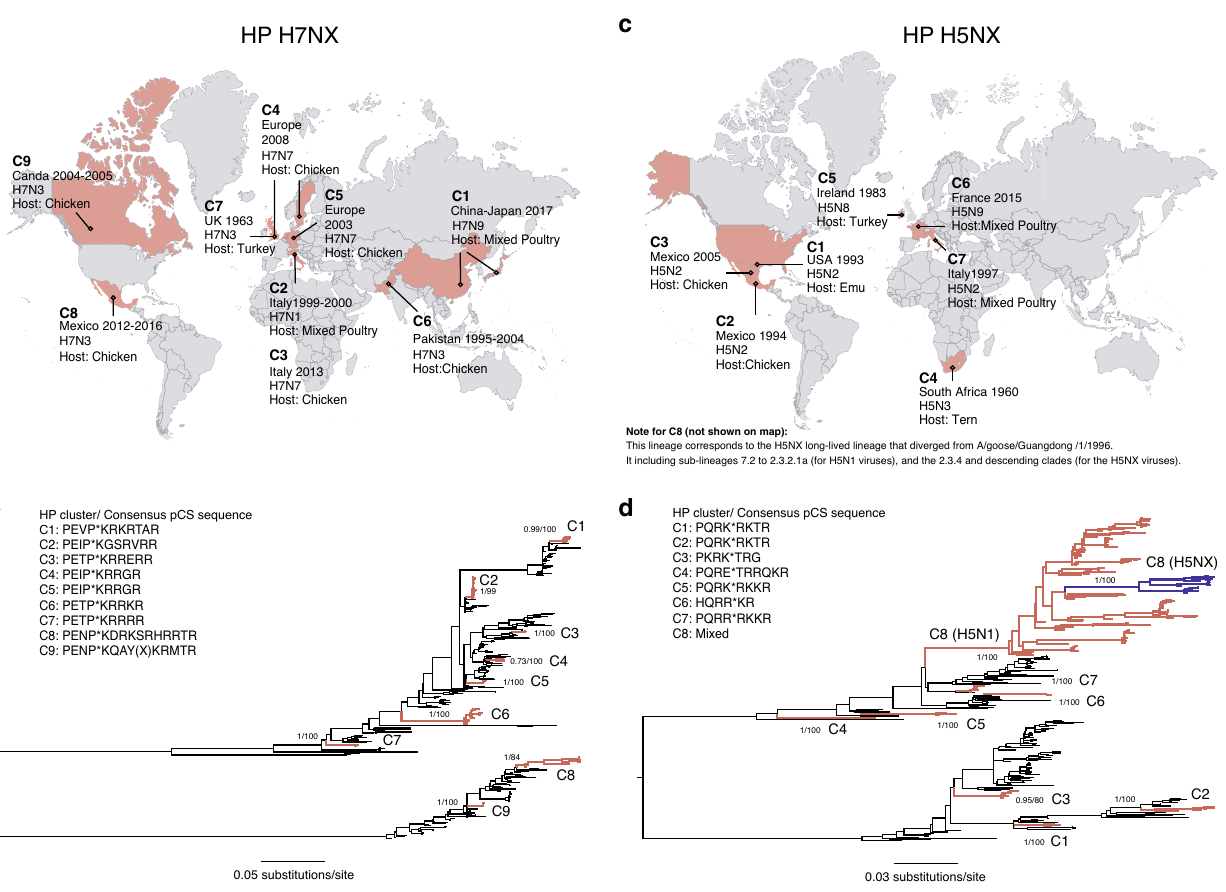
Fig. 2 Historical occurrence of documented HP AIV outbreaks, and independent emergence of HP lineages. a For each H7NX HP case, the recorded date of emergence and duration (in years), the country of emergence (highlighted in red), the virus subtype causing the outbreak, and the reported avian host species are indicated in the map. b Phylogenetic distribution of HP lineages in the H7 subsampled phylogeny. Branches leading to LP sequences are shown in black. HP sequences (highlighted in red) correspond to unique genotypes de fi ned by a pCS (shown next to the phylogeny), as they form independent well-supported lineages (as de fi ned in ‘ Methods ’ , indicated by C1-C9, showing posterior probability and bootstrap support values >80 or 0.8 for nodes of interest), matching the historical occurrence of the documented HP outbreaks. c Historical occurrence of documented H5NX HP outbreaks, following the description used for panel ( a ). Data for C8 is not included, as since 1996, this lineage circulates worldwide. d Phylogenetic distribution of HP lineages in the H5 subsampled phylogeny, following the description used for panel ( b ). Distinct, well-supported HP clusters are highlighted in red (C1-C8). The H5NX HP viruses within cluster C8 (clade 2.3.4 and descending lineages) are highlighted in blue. Maps for the global distribution for the H5NX and H7NX HPAIV were generated with the tool http://gamapserver.who.int/mapLibrary/default.aspx under the CC BY-NC-SA 3.0 IGO license with preprint